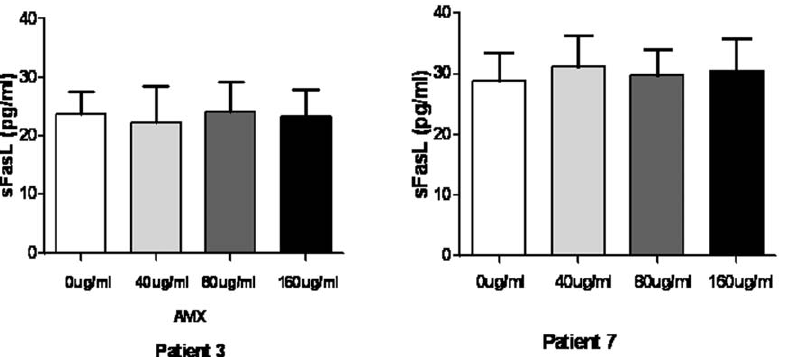
Figure 4. No change of sFasL level in supernatants of PBMCs upon stimulation with higher concentration of amoxicillin. PBMCs from patient 3 and patient 7 were cultured with amoxicillin at concentrations of 0, 40, 80,160 m g/ml. The sFasl levels were then determined by ELISA. A. Patient 3. B, Paitent 7. Results represent mean 6 SD from three independent experiments. * P , 0.05 .